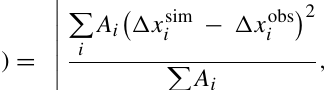
and open land ET of GETA was aggregated similarly using the same land cover (LC) map as in the CLM4.5 simulations, with the LCTs of GETA attributed to the different